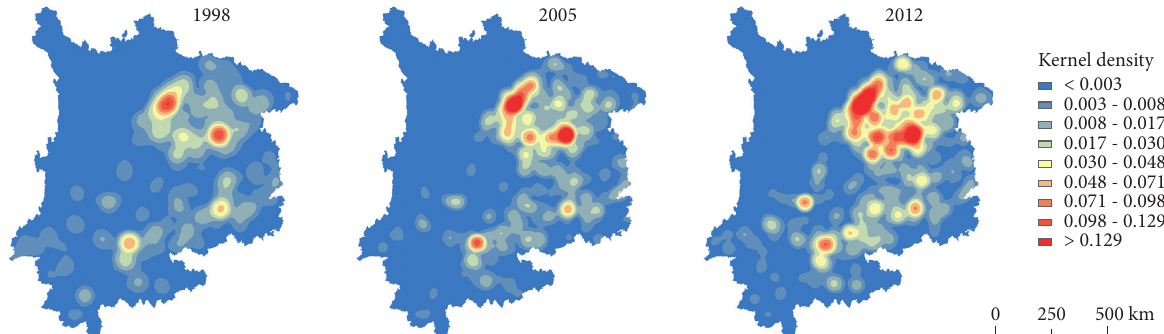
Figure 4: Kernel density estimation of water pollution-intensive enterprises in the upper reaches of the Yangtze River Economic Belt.